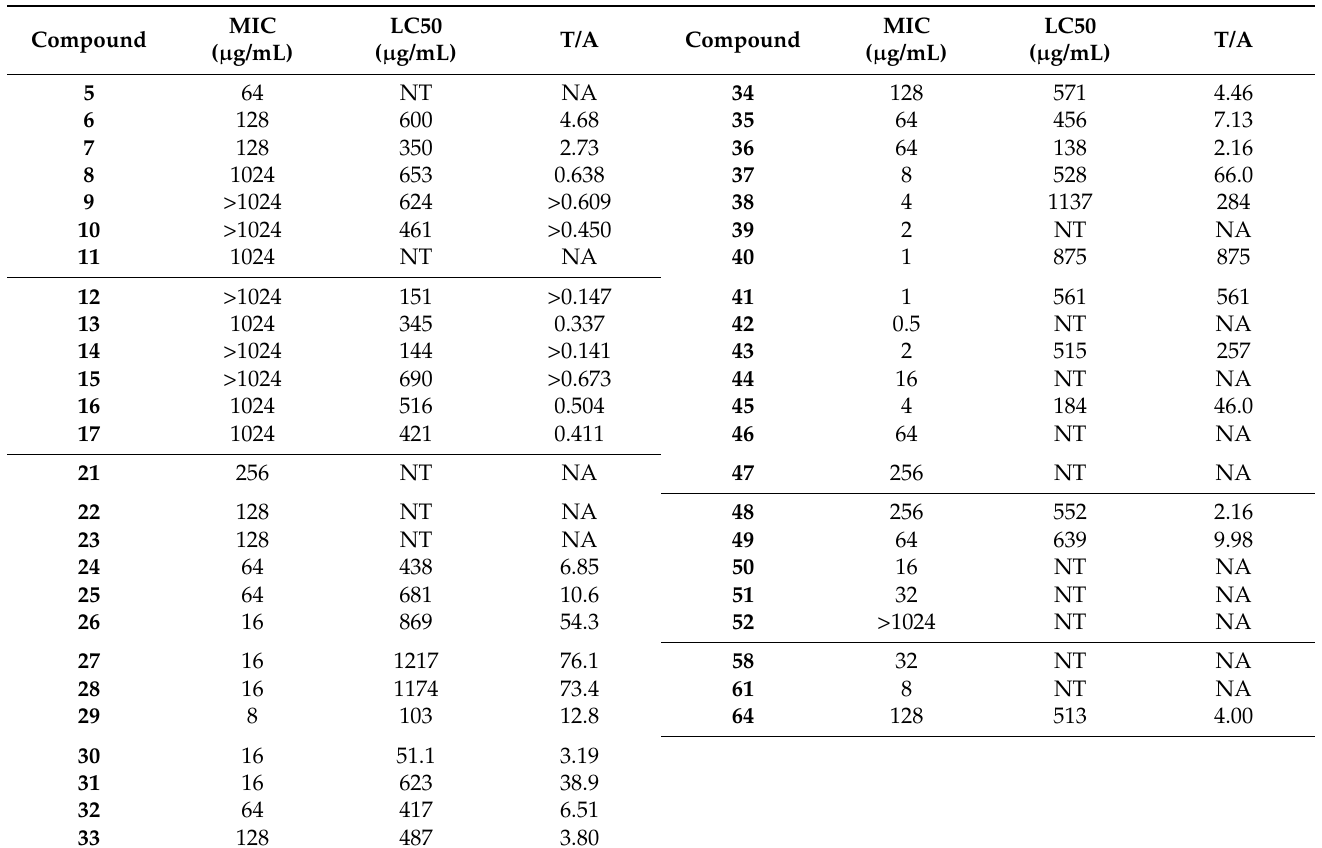
Table 5. Results obtained from cytotoxicity assays, represented by LC50 values and its comparison with MIC values via a toxicity/activity (T/A)